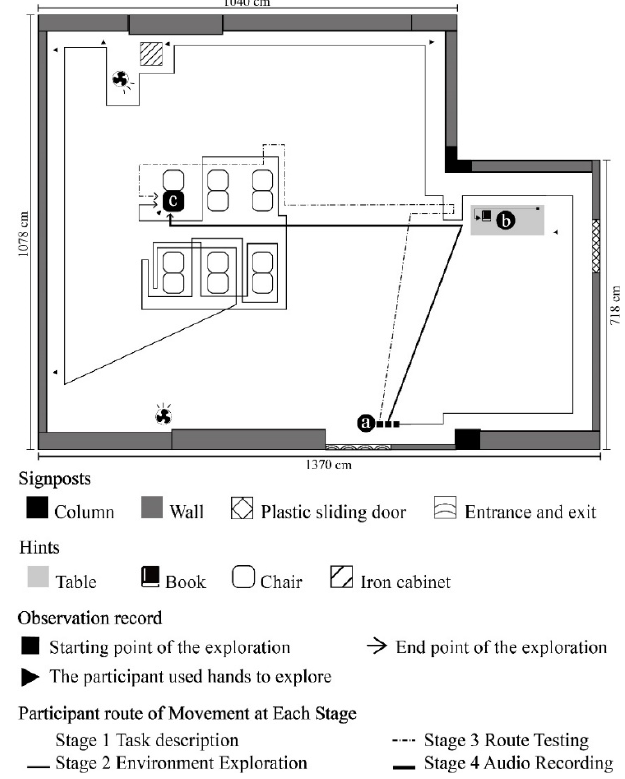
Figure 4. A2 participant’s route of movement at each stage.